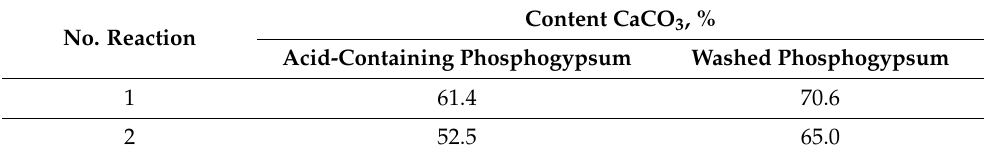
Table 4. The yield of the finished product CaCO 3 (%) depending on the acid residue of phosphogypsum. No. Reaction